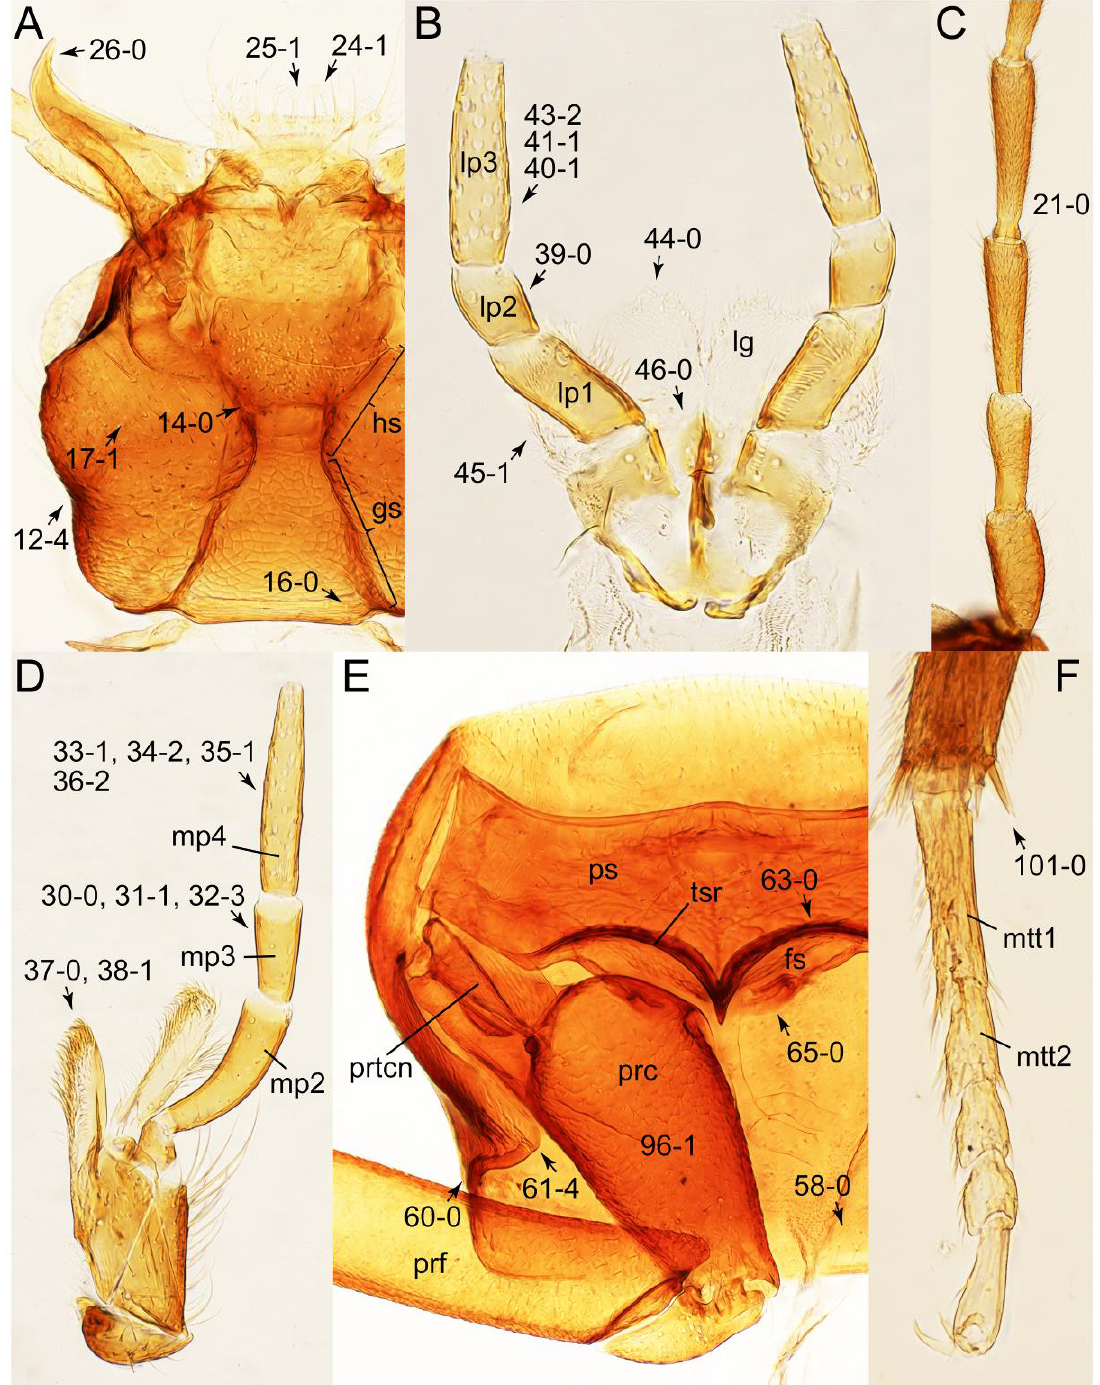
Figure 45. Photographs of body parts of Deropini ( Derops ), enlarged. ( A ) head and mouthparts of Derops divalis , ventral view. ( B ) labium of Derops longicornis , ventral view. ( C ) basal half of right antenna of Derops longicornis , ventral view. ( D ) left maxilla of Derops longicornis , ventral view. ( E ) prothorax and right procoxa of Derops longicornis , ventral view. ( F ) right metatarsus and metatibial spines of Derops divalis , dorsal view. Abbreviations: fs, furcasternum; gs, gular suture; hs, hypostomal suture; lg, ligula; lp1–3, labial palpomere 1–3; mp2–4, maxillary palpomere 2–4; mtt1–2, metatarsomere 1–2; prc, procoxa; prf, profemur; prtcn, protrochantin; ps, prosternum; tsr, transverse sternacoxal ridge of prosternum. Characters and character states (format X-X) are indicated on each